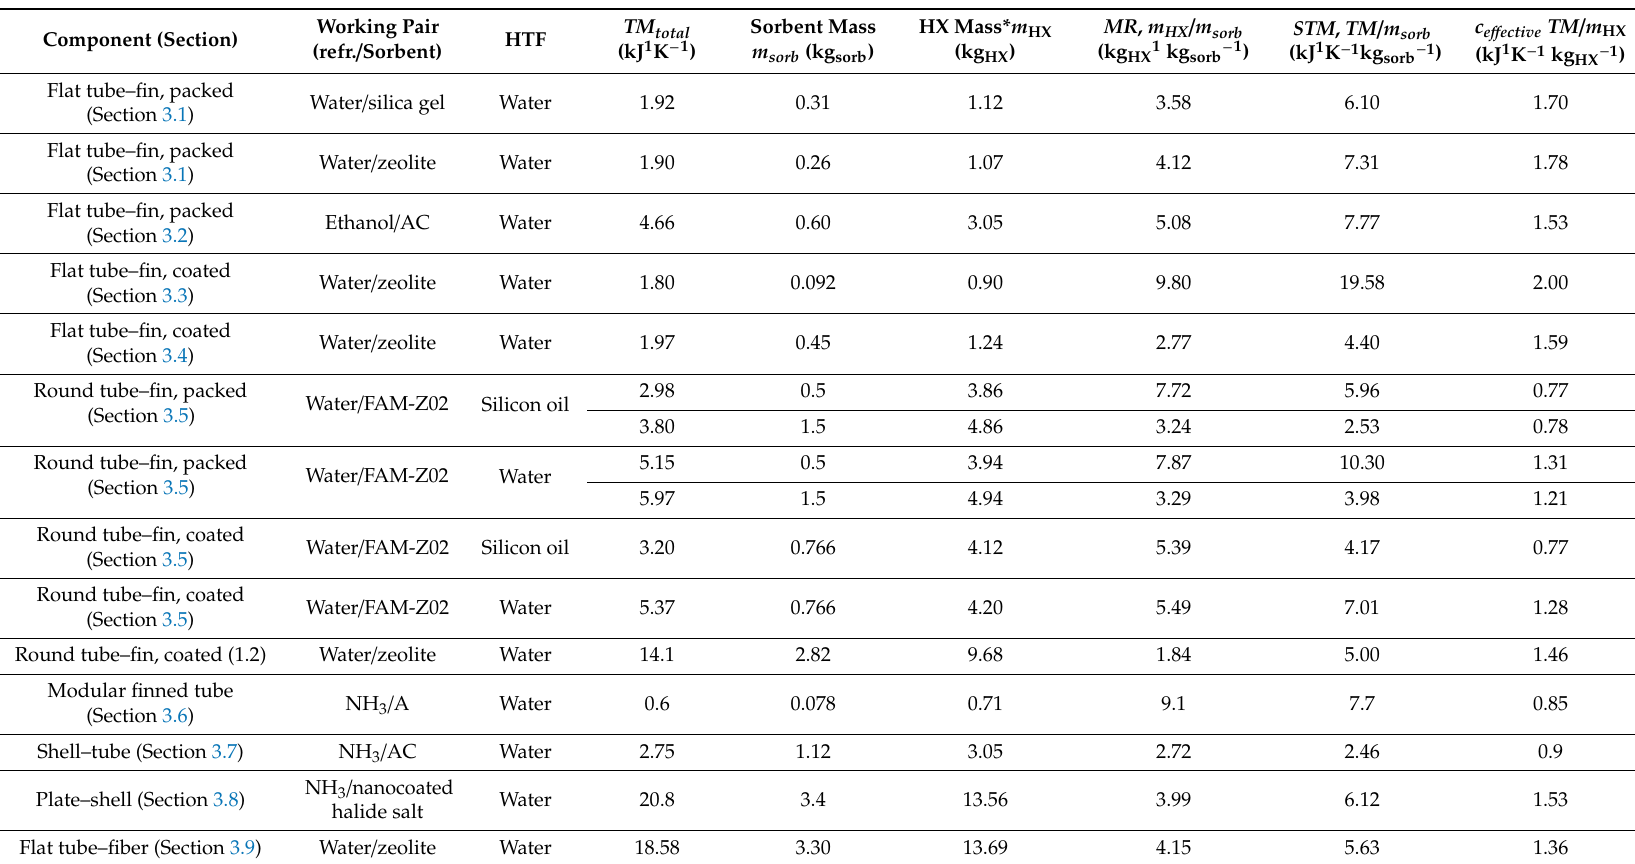
Table 4. Measured mass ratios ( MR ), specific thermal masses ( STM ), and c e ff ective , excluding shells and enclosures for HX-only control volume of adsorber heat exchangers